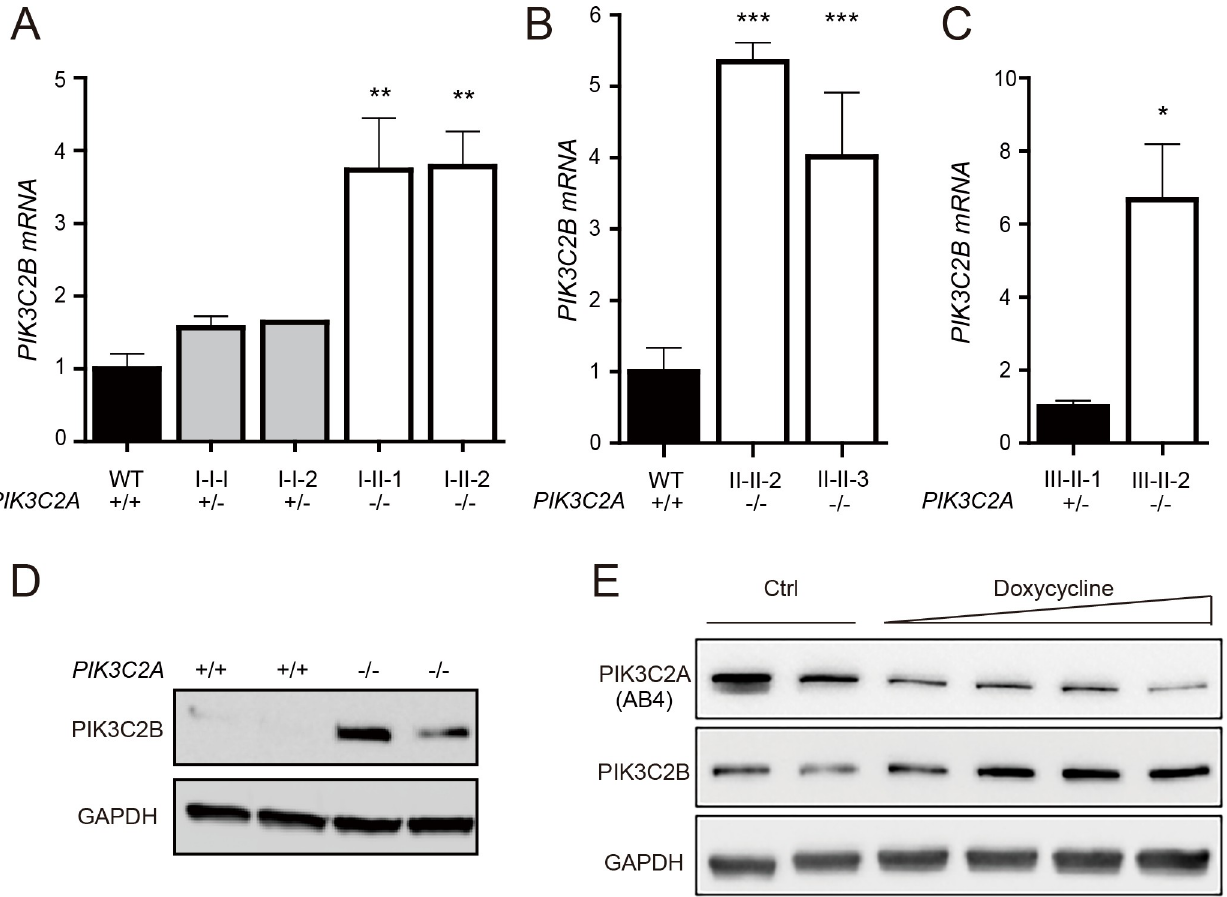
Fig 6. PIK3C2B levels are increased by PIK3C2A deficiency. PIK3C2B mRNA levels were detected by qRT-PCR in (A) Family I, (B) Family II, and (C) Family III. qRT-PCR data is represented as mean ± SEM (n = 3 technical replicates per sample). The WT sample in Fig 6A is based on n = 1 and the WT sample in Fig 6B is based on n = 3, totaling n = 4 different WT samples. (D) PIK3C2B protein levels were detected by Western blotting in Family I from 2 independent experiments. (E) PIK3C2A and PIK3C2B protein levels were analyzed in HeLa cells by Western blotting following doxycycline inducible shRNA mediated knockdown of PIK3C2A. Data shown is representative from 3 independent experiments. � indicates p < 0.05, �� indicates p < 0.01. ��� indicates p < 0.0001.